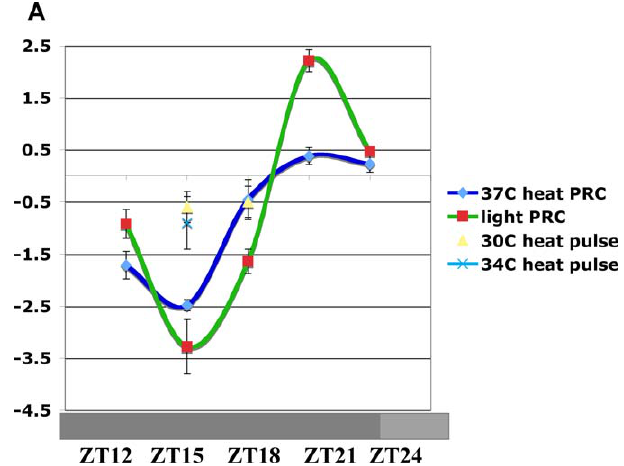
Figure 1. Heat Pulse–Mediated Phase Delays of Wild-Type Flies Require 37 8 C Phase response curves for CS flies after heat (circle) versus light pulse (square). Flies were entrained for 3 d in 12 h:12 h LD cycles and pulsed for 30 min of light and 30 8 C, 34 8 C, and 37 8 C heat pulse (HP) during the last night of the LD entrainment cycle, after which the flies were released in constant darkness for 5 d. Phase changes were calculated by comparing behavioral offsets of light or HP treated flies 3 d after the pulse to the behavior of the control group of the same genotype that did not receive a pulse. The calculations were made by MATLAB software using previously described methods [46]. Phase delays and phase advances are plotted ( 6 SEM) as negative and positive values respectively. In all cases, the experiments were repeated at least twice with similar results. Data were pooled from the following number of flies (each pair of values referring to wild-type light-pulsed and wild-type 37 8 C heat-pulsed): control: 32, 32; pulse at ZT12: 32, 22; pulse at ZT15: 32, 26; pulse at ZT18: 23, 26; pulse at ZT21: 24, 19; and pulse at ZT24: 29, 27.